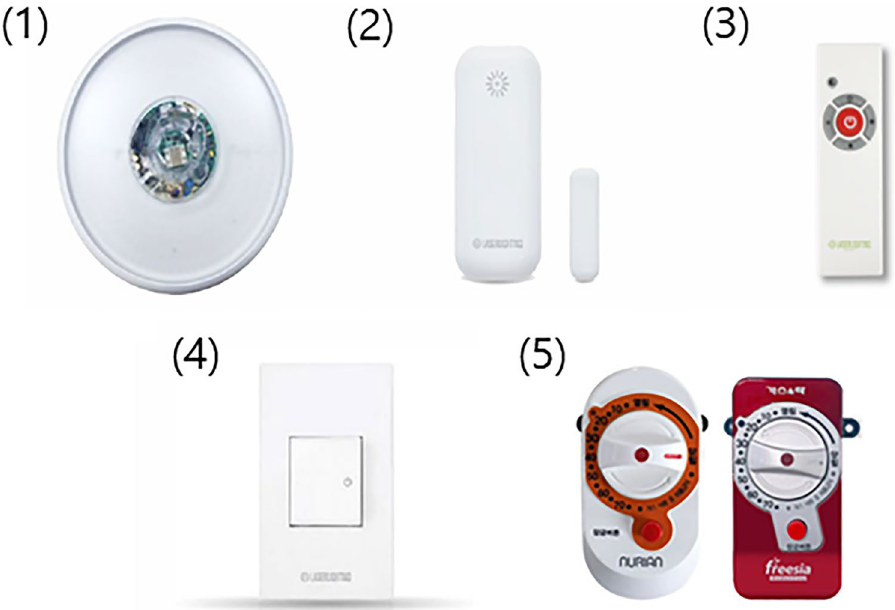
Figure 1. Five Internet of Things (IoT) devices used in the study. (1) Human sensing LED lighting (entrance ceiling) senses user’s motion and turns on the light, (2) Occupancy sensor (door) also detects user’s movement, (3) Remote controller has buttons for turning on/off the lights and making SOS call, (4) Wall switch can turn on/off the light and send usage log to communication module in LED lighting, (5) Automatic gas circuit breaker blocks a gas flow when an individually set time passes. Data (usage log of LED lighting, measurement value of occupancy sensor) from all devices except the automatic gas circuit breaker, are all gathered in communication module of LED lighting, and sent to a main server every 5 min without a personal home wired or wireless network. LED light emitting